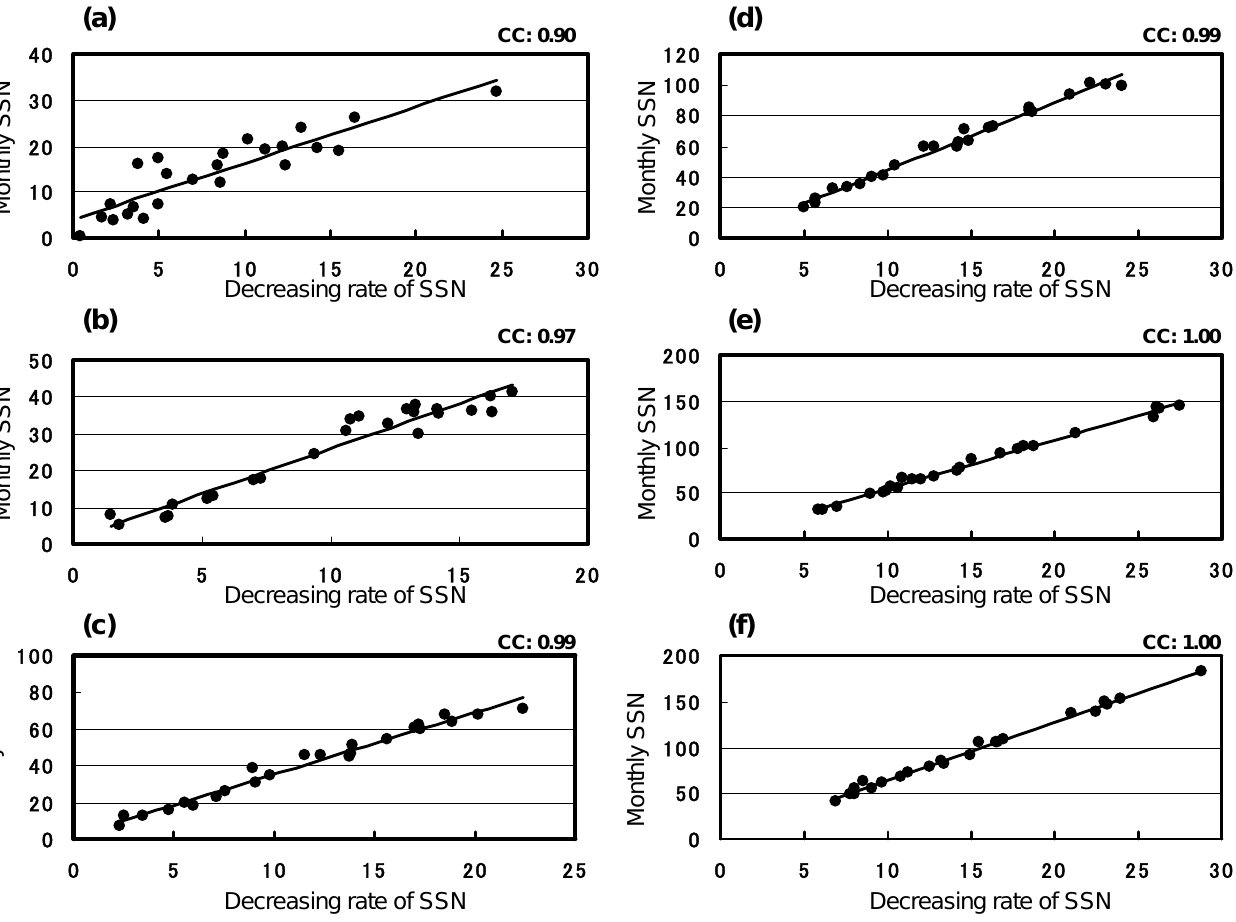
Fig. 6. (a) Monthly smoothed sunspot number one year before the minimum versus average rate of decrease of monthly smoothed sunspot number during a one-year period before the minimum. Panels (b) , (c) , (d) , (e) and (f) are the same as panel (a) but for two-year, three-year, four-year, five-year and six-year periods before the minimum, respectively.